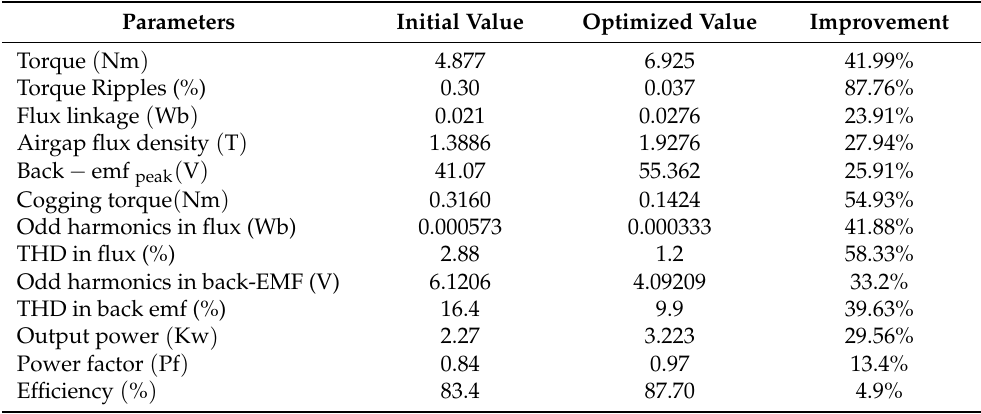
Table 4. Performance comparison of initial and optimized